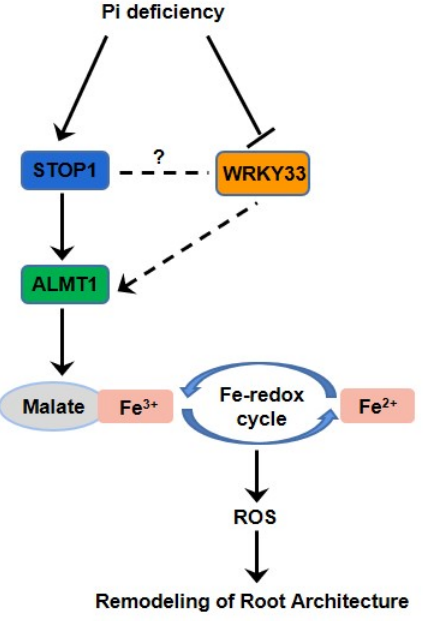
Figure 7. A proposed model of WRKY33’s regulation of the Pi-deficiency responses. Arrows indicate promotion, and perpendicular lines indicate suppression. Broken lines indicate indirect interactions.